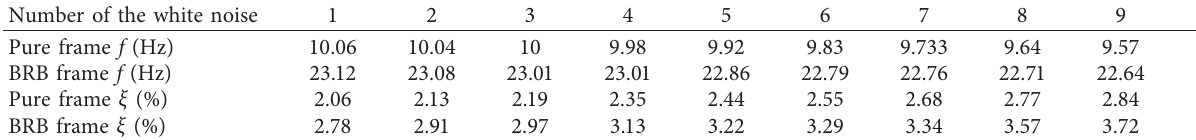
Table 4: Natural frequency and damping ratio of the specimen.